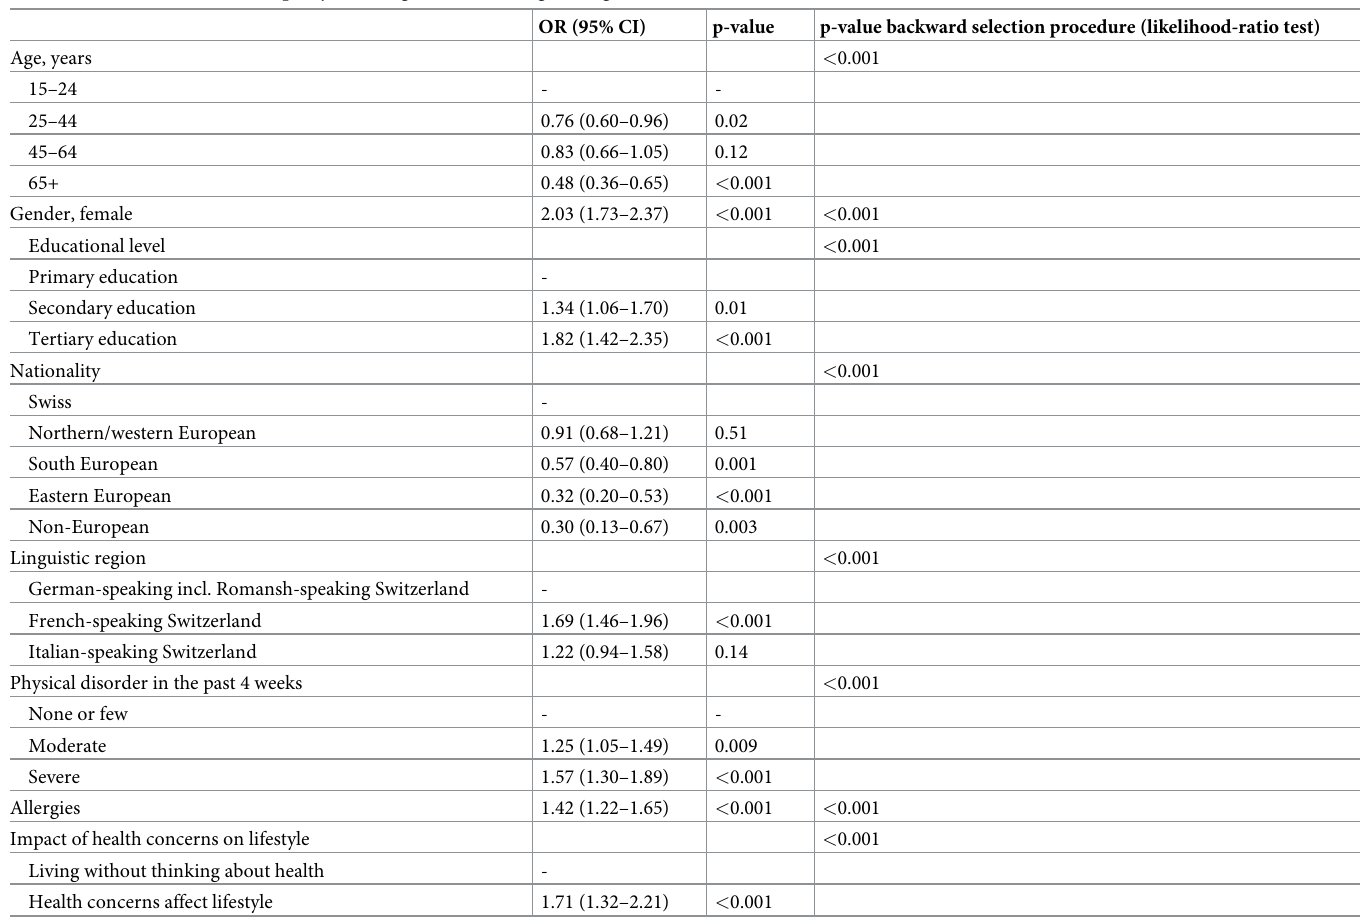
Table 5. Determinants of homeopathy use using multivariate logistic